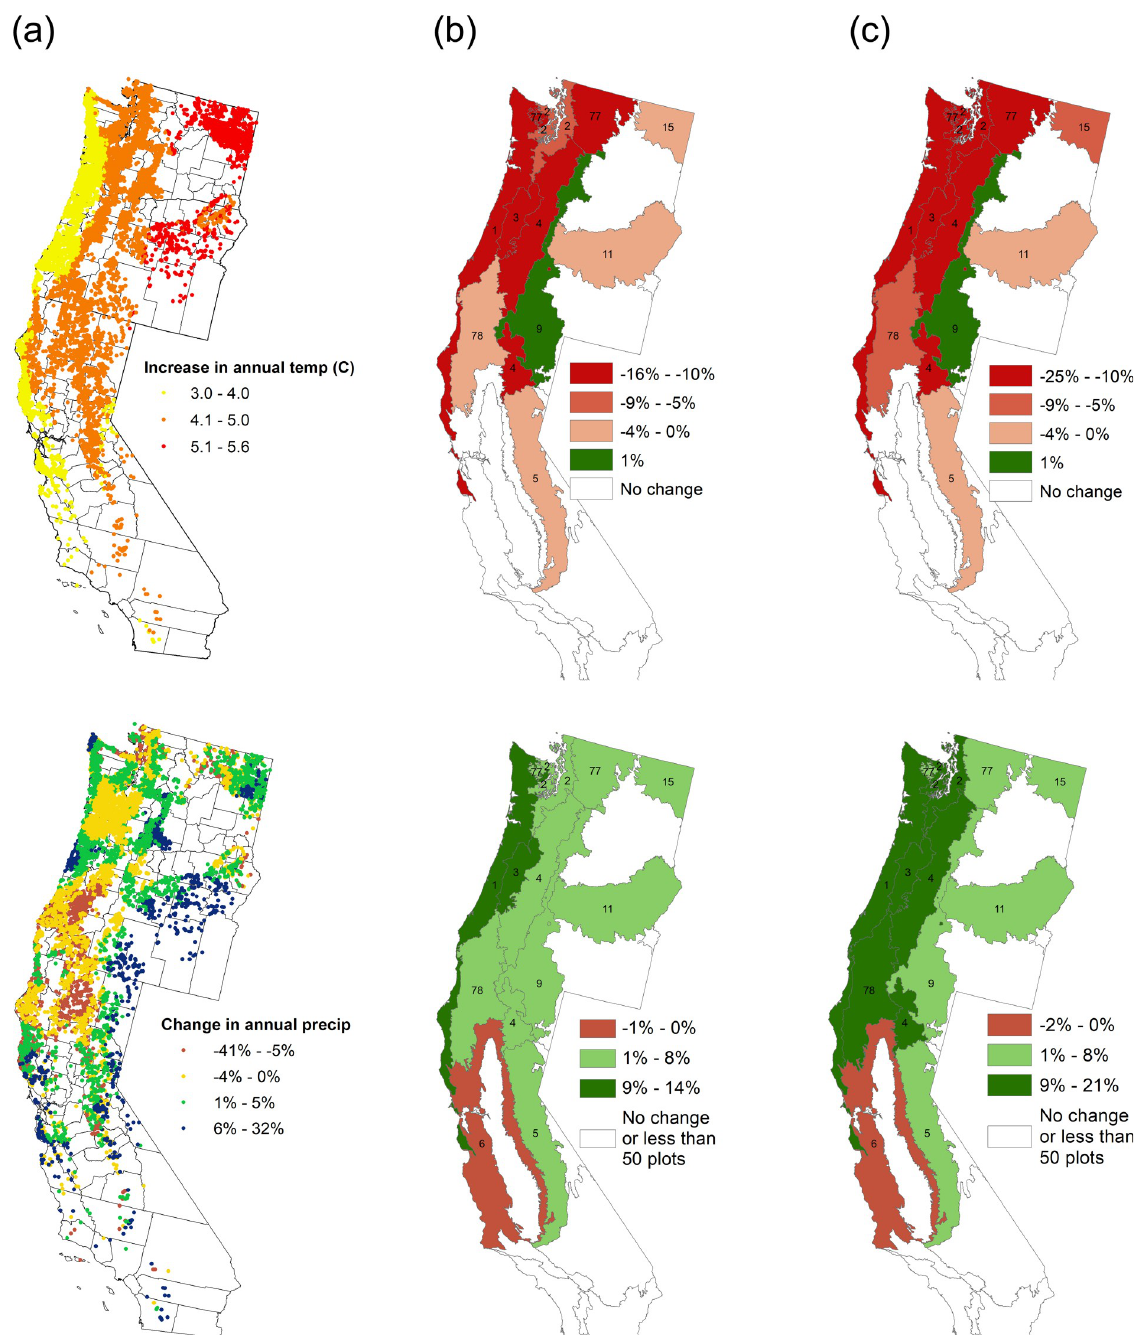
Fig 3. Through 2100, (a) major climatic changes, and modeled effects of (b) climate change only or (c) climate change + carbon pricing, for Douglas-fir (top) and hardwood (bottom) forest types. Dots in a. represent FIA plots (not to scale). Each number in b. and c. corresponds to level 3 ecoregions (see S6 Fig for ecoregion names). The maps were created by the authors based on the NCAR CCSM4 (a) and our simulation results (b and c) with the ArcMap software, an ArcGIS application developed by Esri [41], based on the level 3 ecoregions map from the U.S. Environmental Protection Agency (EPA) [42]. a. Projected temperature change (top) and precipitation change (bottom) under RCP 8.5. b. Percentage point difference between baseline and climate change only scenario for Douglas-fir (top) and hardwood (bottom) forest types. c. Percentage point difference between baseline and climate change + carbon pricing scenario for Douglas-fir (top) and hardwood (bottom) forest types.